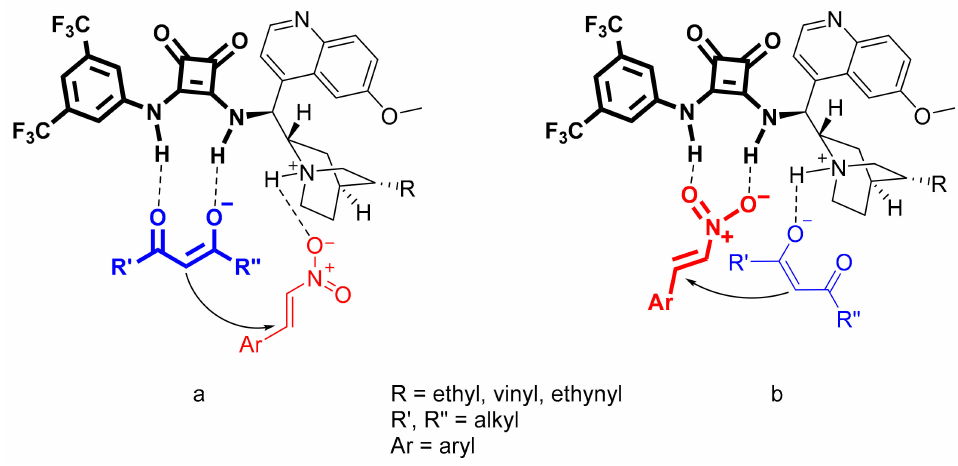
Figure 1. Two possible mechanisms ( a and b ) for Michael addition in the presence of bifunctional H-bond